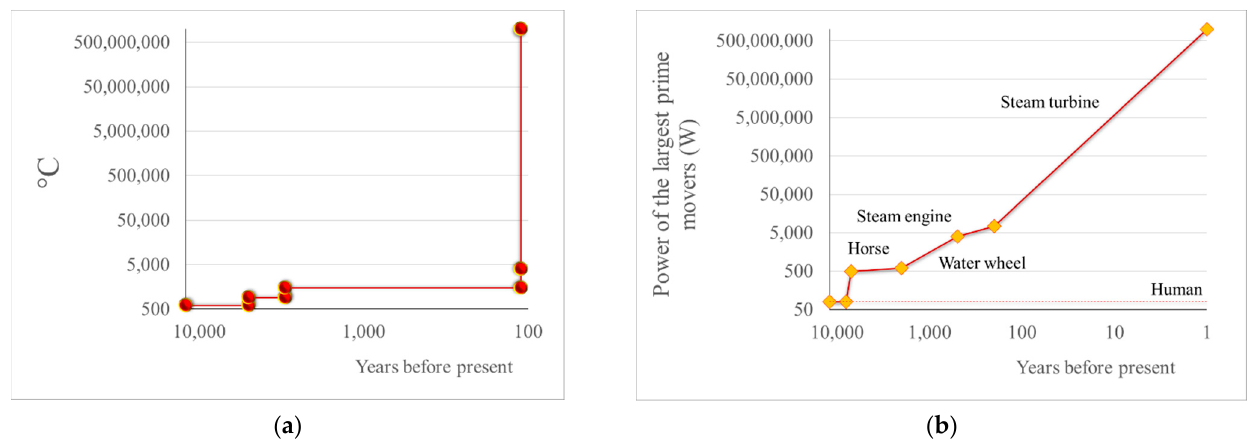
Figure 7. ( a ) Temperatures created by human actions in different eras. ( b ) Power of the largest prime movers in different eras [74–76] (diagrams present data in logarithmic scale as order of magnitude).